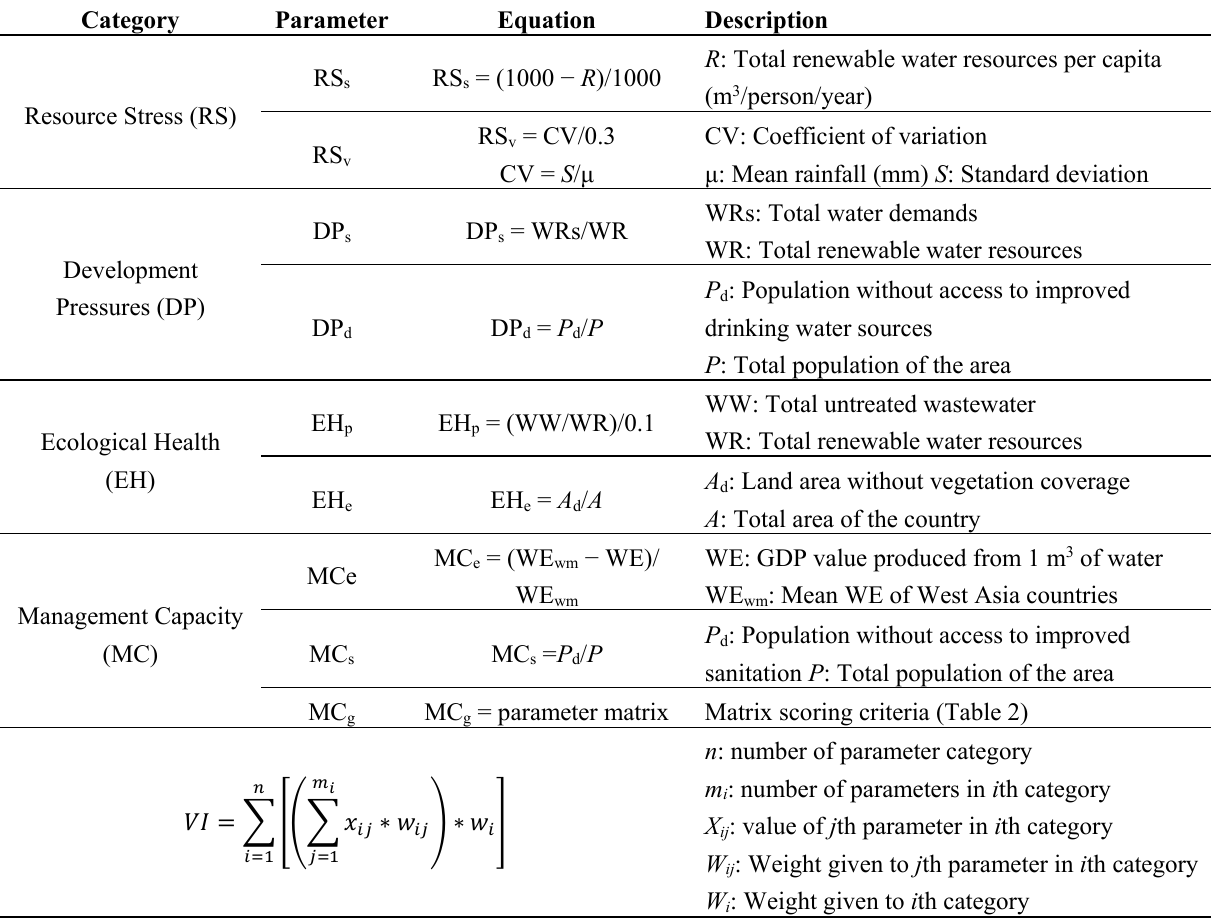
Table 1. Equations used for calculation of all categories and parameters of vulnerability index of water resources in the study